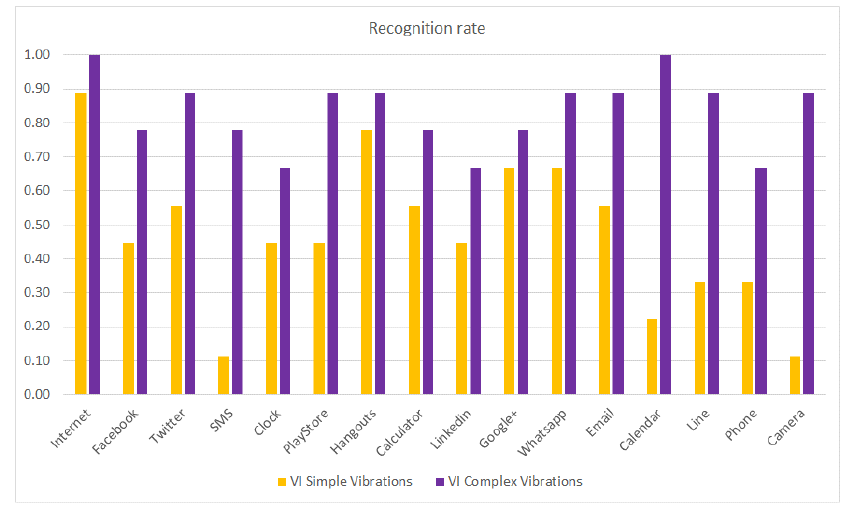
Figure 8. Recognition rate per haptic icon for VI people using simple and complex vibration patterns.